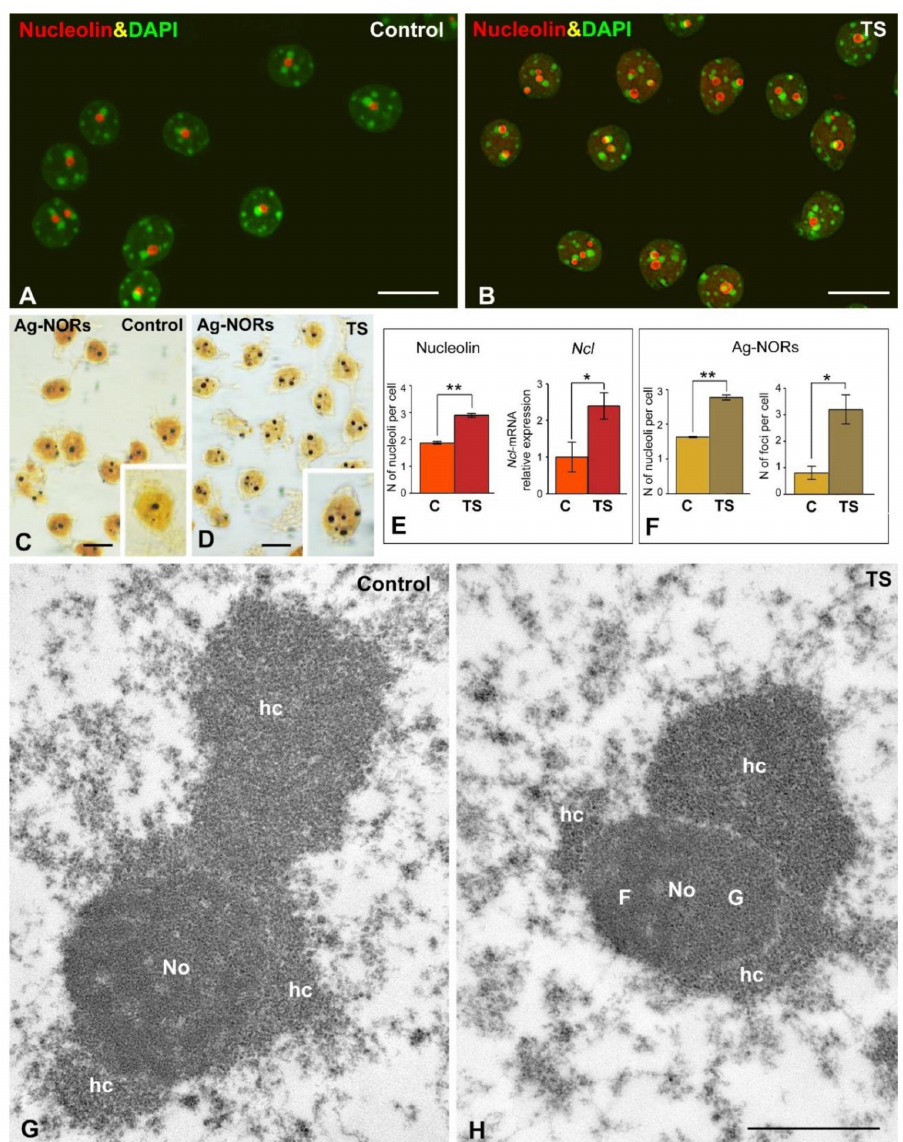
Figure 3. Trisomy causes an increase of nucleoli and Ag-NORs number in the GCs of TS mice. ( A , B ) Nucleolin immunolabeling counterstained with DAPI of dissociated GCs from control ( A ), and TS ( B ) mice. Note the apparent increase in the number of nucleoli in TS GCs. ( C , D ) Dissociated GCs from control ( C ), and TS ( D ) mice stained with the silver nitrate procedure for Ag-NOR proteins. Whereas large silver-impregnated spots correspond to Ag-NOR-containing nucleoli, the smaller foci (insets) belong to extranucleolar Ag-NORs. Scale bars: A-D: 5 µ m. ( E ) The quantitative analysis of the mean number of nucleolin-positive nucleoli per GC shows an increase in TS GCs relative to control ones. This significant rise in the number of nucleoli correlates with a parallel increase in the expression levels of Ncl mRNA. ( F ) The quantitative analysis of the distribution of Ag-NORs in nucleoli and extranucleolar tiny foci reveals an increase in both the number of nucleoli and extranucleolar Ag- NOR foci in TS GCs. E and F: Data is presented as means + SEM of three independent experiments. ( G , H ) Electron micrographs of nucleoli (No) from control ( G ), and TS ( H ) GCs surrounded by prominent masses of perinucleolar heterochromatin (hc). Both nucleoli exhibit a predominance of the granular component ( G ). F: fibrillar component. Scale bar: 1 µ m. *: p < 0.05, **: p < 0.01. Ag-NORs = argyrophilic nucleolar organizer regions; C = control mice; G = granular component; F = dense fibrillar component; hc = heterochromatin; No = nucleolus; TS = Ts65Dn